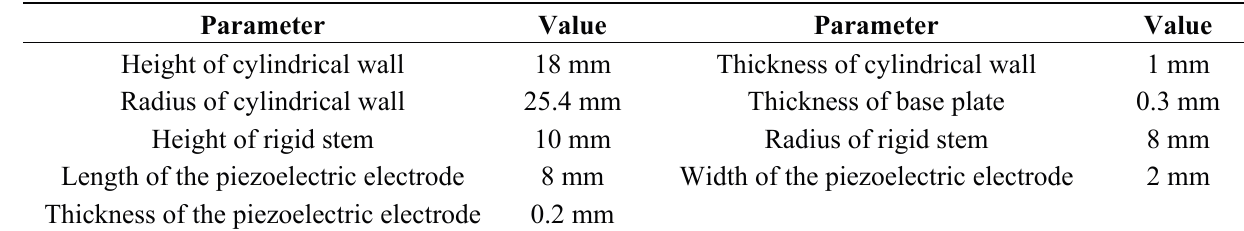
Table 1. Geometry parameters of the